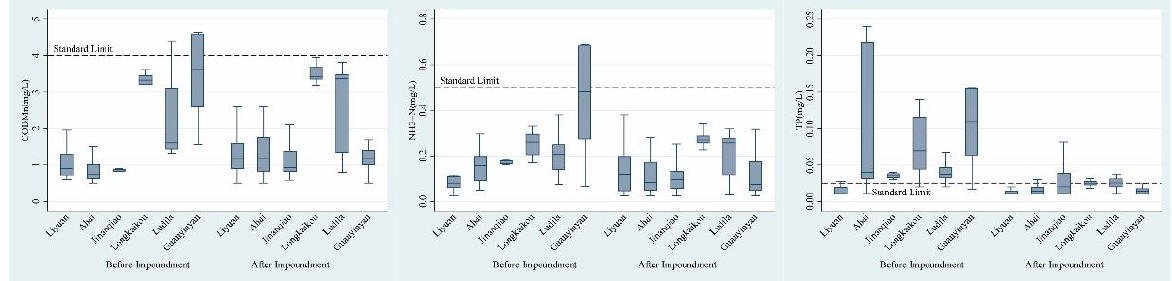
Figure 3. Boxplot of water quality indicators before and after water impoundment at six hydropower stations on the Jinsha River.